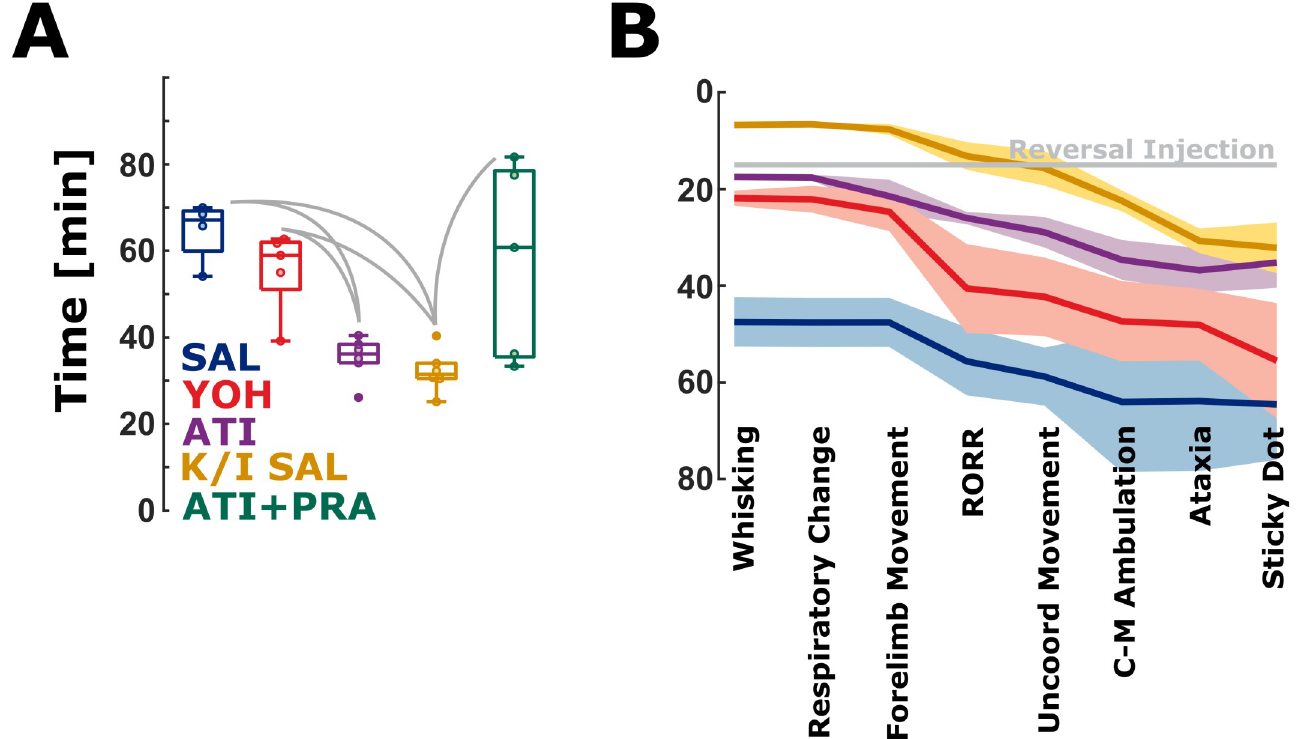
Fig 4. Timing of waking behavior incidence varies with reversing agent, while order is generally maintained. A) Animals that did not receive alpha receptor agonists or antagonists (ketamine+isoflurane+saline) notice the sticky dot earlier than animals from the saline (SAL) and yohimbine (YOH) group The Kruskal- Wallis test indicated a significant difference among groups (p = 0.0052, χ 2: 14.79). The significant differences between the groups exclusive K/I-SAL (K/I: ketamine/isoflurane) are reported in the results section. Time to sticky dot notice for K/I-SAL was significantly shorter when compared to SAL, YOH. There was no significant difference when compared to the atipamezole (ATI) group The solid, gray lines indicate significant differences between groups. B) All measured waking behavior hallmarks compared between the groups. The gray line indicates time of reversal injection, 15 minutes post-ketamine/xylazine injection. The solid lines present the mean and the 95% confidence interval on the